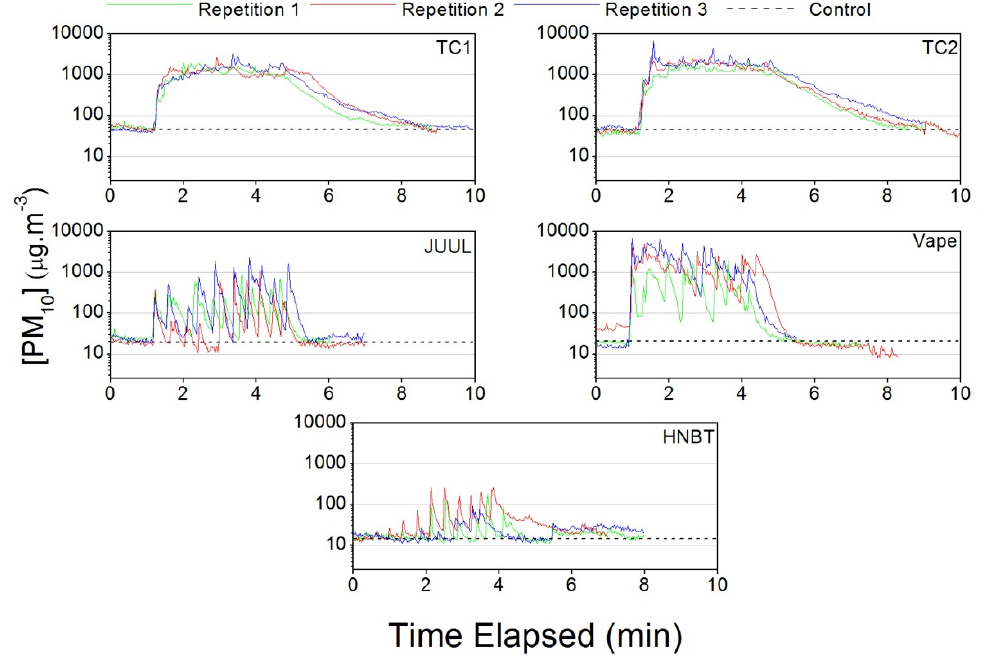
Figure 6. PM 10 concentrations measured in the car during traditional cigarette (TC1 and